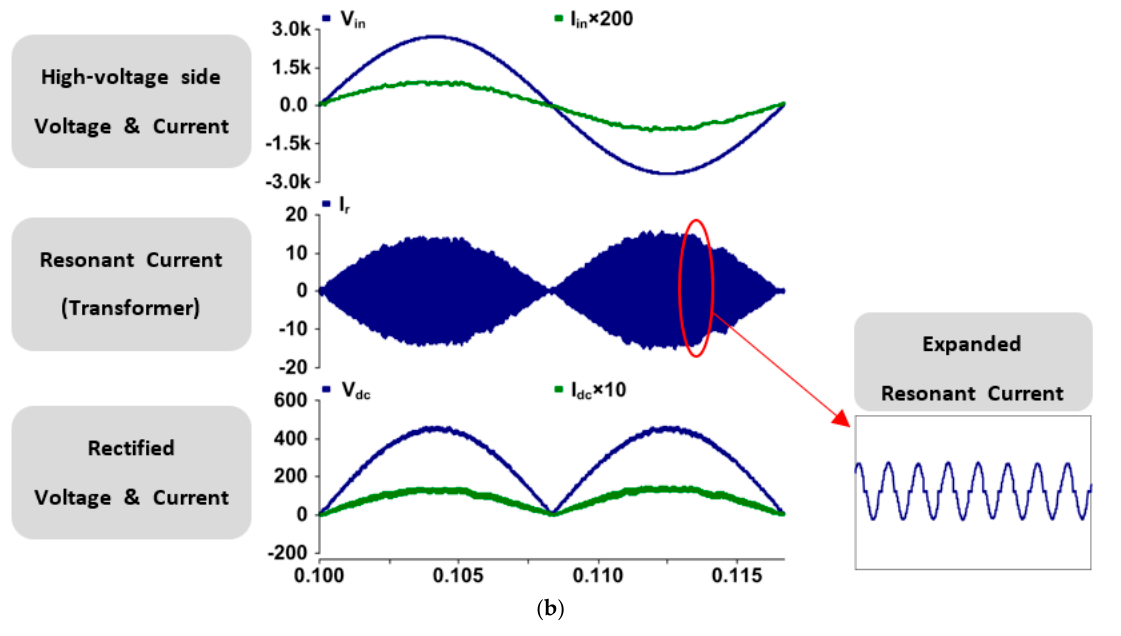
Figure 3. Gating pulses and operation analysis results of AC/DC converter: ( a ) gating pulses for six switches; ( b ) operation analysis results.